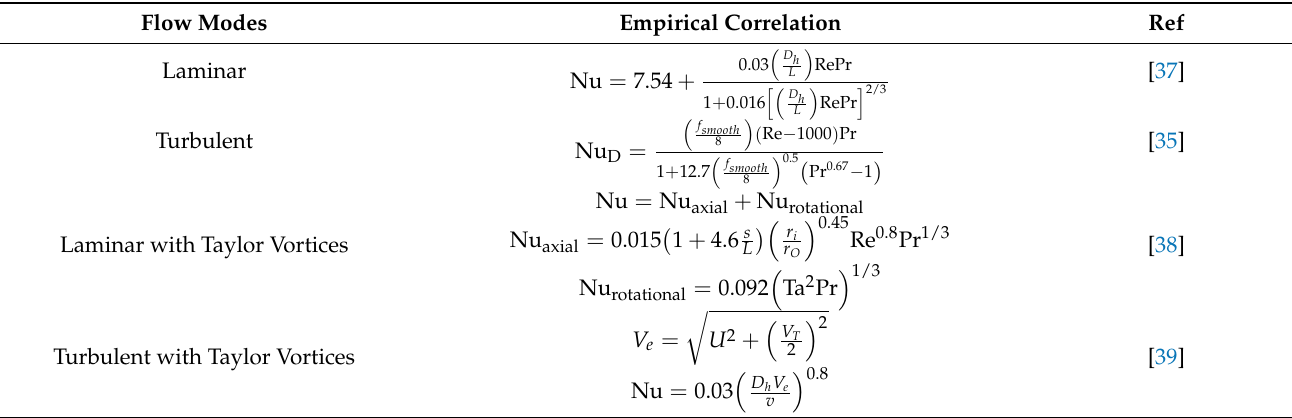
Table 1. Correlations for computing the air gap convection coefficient [35,36]. Flow